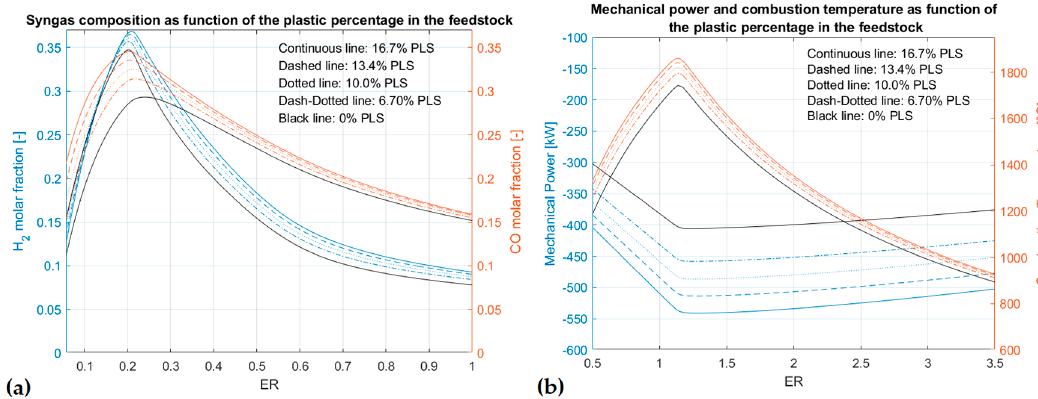
Figure 12. ( a ) Syngas and feedstock LHV as a function of plastic fraction; ( b ) cold gas efficiency as a function of the plastic fraction.